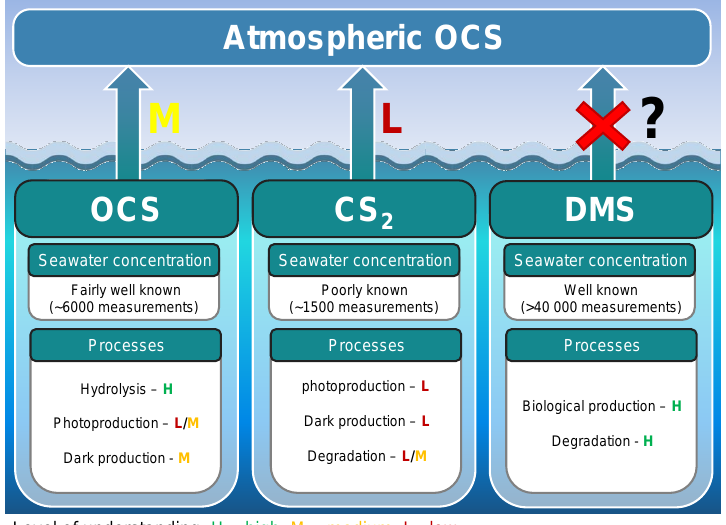
Figure 8. Marine contribution to the atmospheric OCS loading from direct and indirect (CS 2 ) emissions. The sea surface concentration deter- mines the magnitude of the oceanic emissions, and the uncertainty in global emissions decreases with increasing numbers of measurements. The understanding of processes is important to extrapolate from small-scale observations to a regional or global scale and varies between a low level of understanding for CS 2 (i.e., few process studies available) to a medium level of understanding for OCS (i.e., several process studies available, but considerable spread in quantifications across different locations). We recommend reconsidering the contribution of oceanic DMS